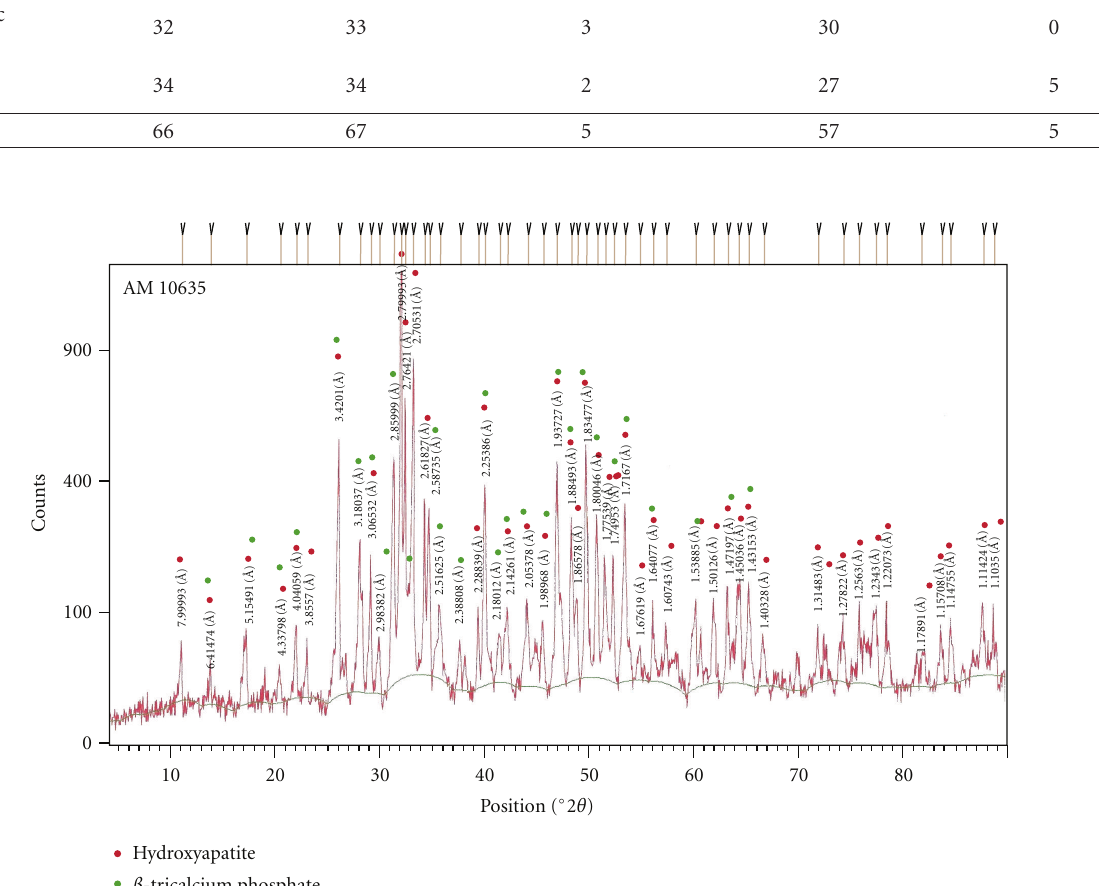
Figure 1: X-Ray di ff raction of bioceramics. This analysis shows the crystalline phases of the BCP and the HA/ß-TCP ratio which corresponds to 65%/35%, respectively.